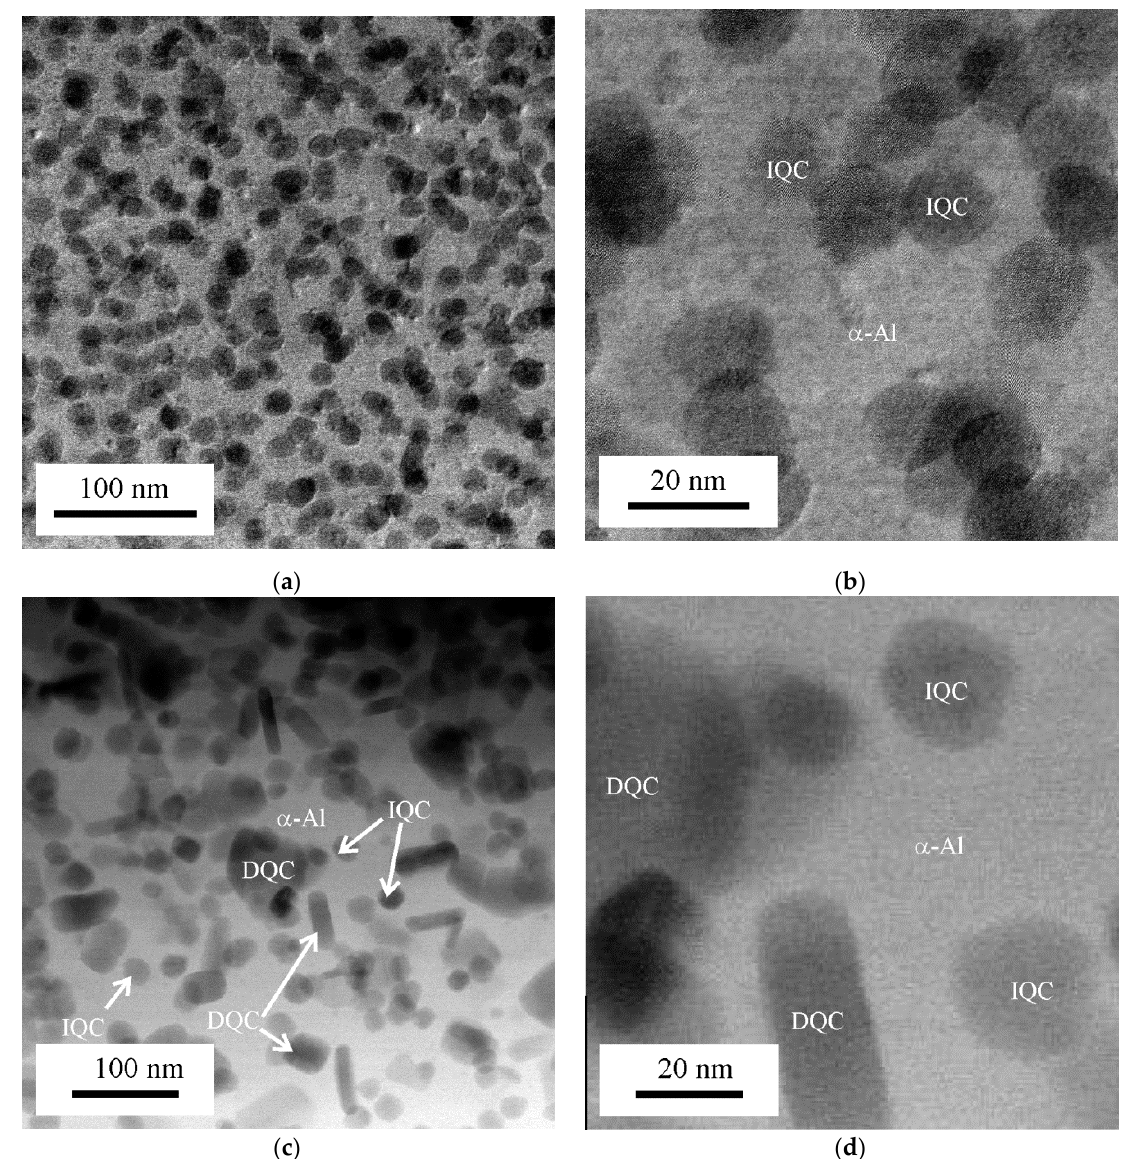
Figure 6. Bright-field TEM micrographs of the alloy Al 95.4 Mn 1.8 Cu 1.6 Be 1.2 ( a , b ) heat-treated at 300 °C for 168 h and ( c , d ) heat-treated at 400 °C for 1 h (orientation close to [001]-Al). Sample diameter 4 mm. (IQC—icosahedral quasicrystal, DQC—decagonal quasicrystal).